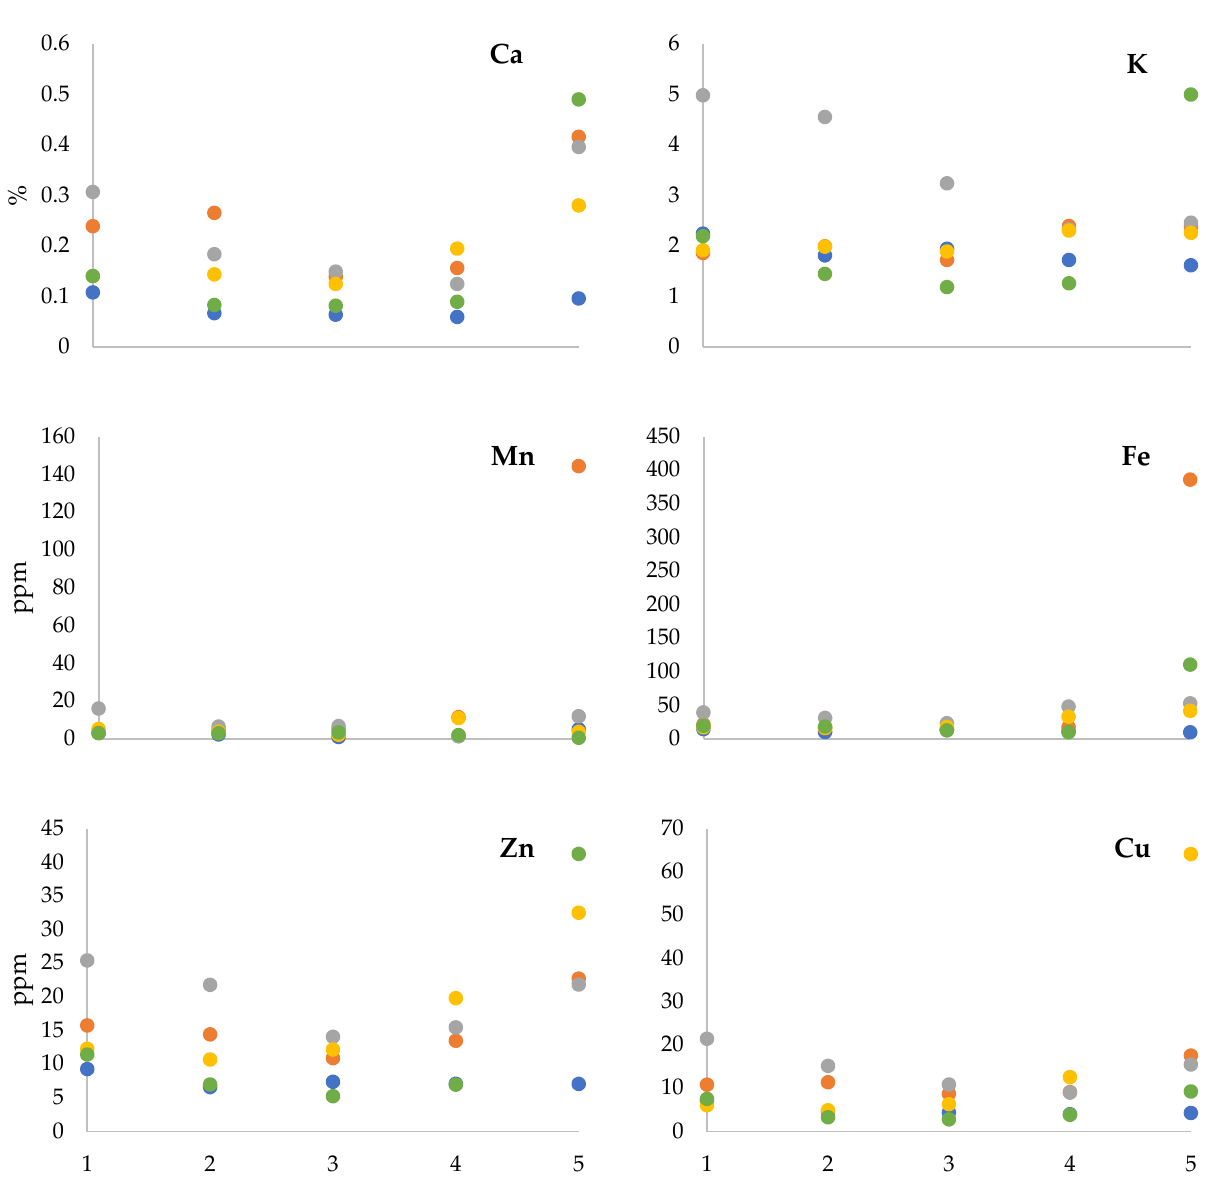
Figure 2. Distribution of Ca, K, Mn, Fe, Zn and Cu of Rocha pear fruits by region (from center to epidermis, zone 1 to 5, respectively), at harvest. Treatments Ctr, T0.1, T0.6, T0.8 and T1.6 (corresponding to the control and leaves spraying with 0.1 and 0.6 kg · ha − 1 Ca(NO 3 ) 2 and 0.8 and 1.6 kg · ha − 1 CaCl 2 , respectively), are represented by colors blue, orange, grey, yellow and green, respectively. Standard errors were lower than 1%.